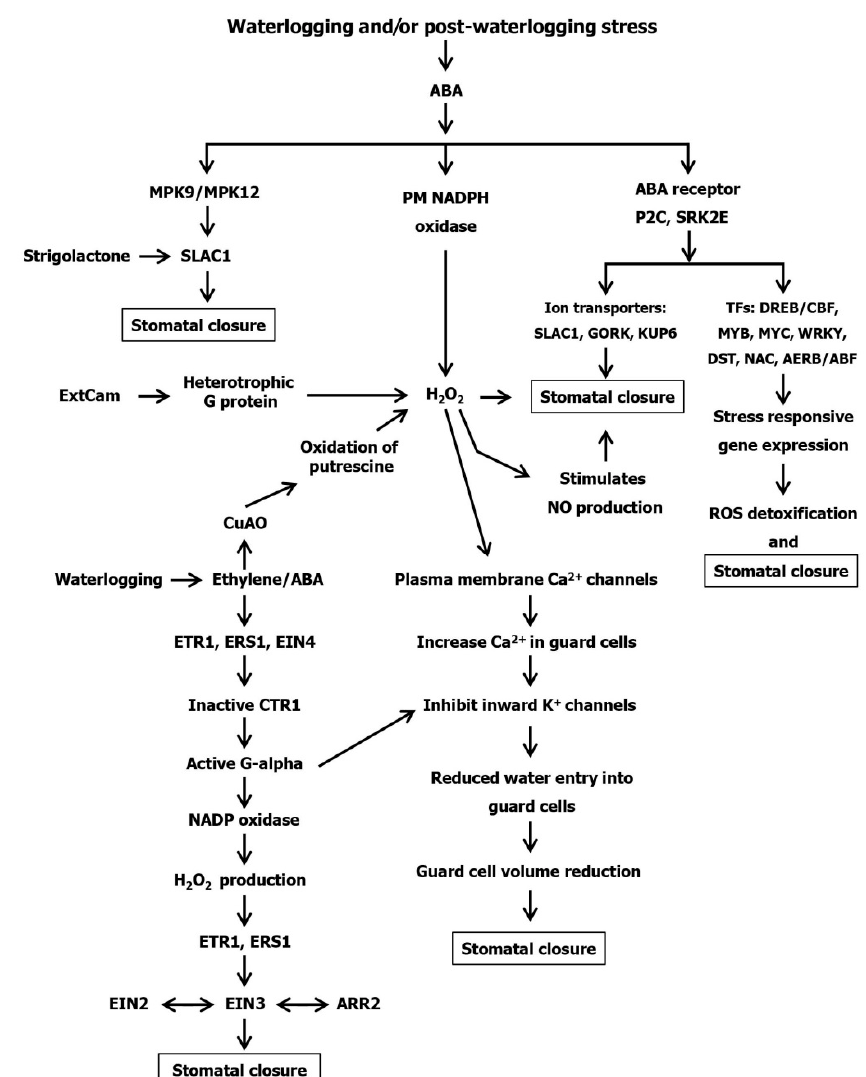
Figure 4. Proposed model for hormone mediated stomatal closure under waterlogging and/or post-waterlogging stress conditions. Modified figure [84]. Ethylene and/or ABA are directly or indirectly enhance H 2 O 2 production under waterlogging and/or post-waterlogging stress conditions. H 2 O 2 is directly responsible for closing of stomata or indirectly increasing Ca 2+ in the guard cell for stomatal closure by reducing the volume of the guard cell. ABA: Abscisic acid; AREB/ABF: (ABA)-responsive element binding proteins/ABRE(ABA-responsive element)-binding factors; ARR2: 2-component response regulator; CTR1: Constitutive triple response 1; CuAO: Copper amine oxisase; DREB/CBF: Dehydration-responsive element-binding/C-repeat binding factor; DST: Drought and salt tolerance; EIN: Ethylene Insensitive; ERS1: Ethylene response sensor 1; ETR1: Ethylene receptor 1; ExtCaM: Extracellular Calmodulin; GORK: Guard cell outward-rectifying K+; KUP6: K+ uptake transporter 6; MPK3/9: Mitogen-activated protein kinase3/9; MYB: My elo b lastosis; MYC2: My elo c ytomatosis; NAC: NAM (No apical meristem), ATAF (Arabidopsis transcription activation factor) and CUC (Cup-shaped cotyledon) transcription factor; P2C: Protein phosphatase 2C; ROS: Reactive oxygen species; SLAC1: Slow anion channel-associated 1; SRK2E: SNF1 (Sucrose nonfermenting 1)-related protein kinase 2; WRKY: W-tryptophan, R-arginine, K-lysine, Y-tyrosine.